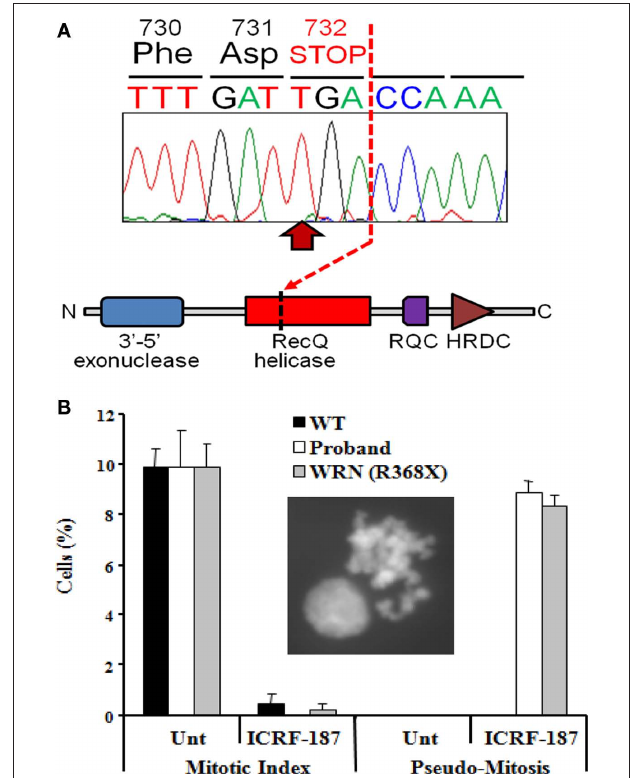
FiguRE 3 | identification of a loss-of-function mutation in the WRN helicase (A). Homozygous p.Arg732X mutation in the WRN gene found in the proband, leading to truncation of the RecQ helicase domain and loss of both RecQ C-terminal (RQC) and helicase RNAseD C-terminal (HRDC) domains which mediate interaction with DNA and proteins by the WRN protein. (B) Impairment of the DNA decatenation checkpoint in lymphoblastoid cells from the proband. The inset shows a representative pseudo-mitosis. WT, wild type; Unt, untreated; WRN (R368X), cells from a Werner’s syndrome patient homozygous for the p.Arg368X pathogenic